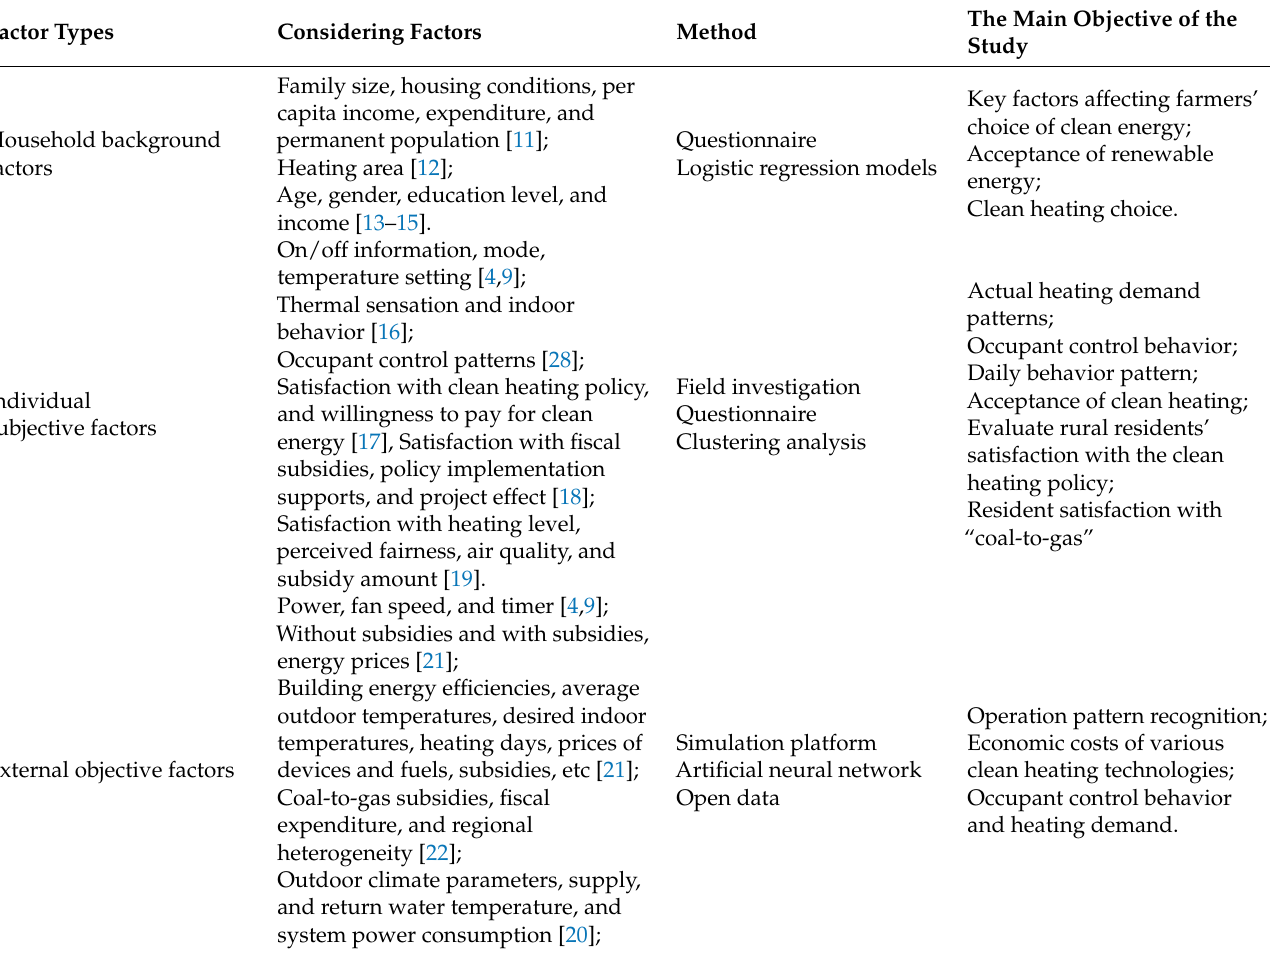
Table 1. Influencing factors of households’ clean heating